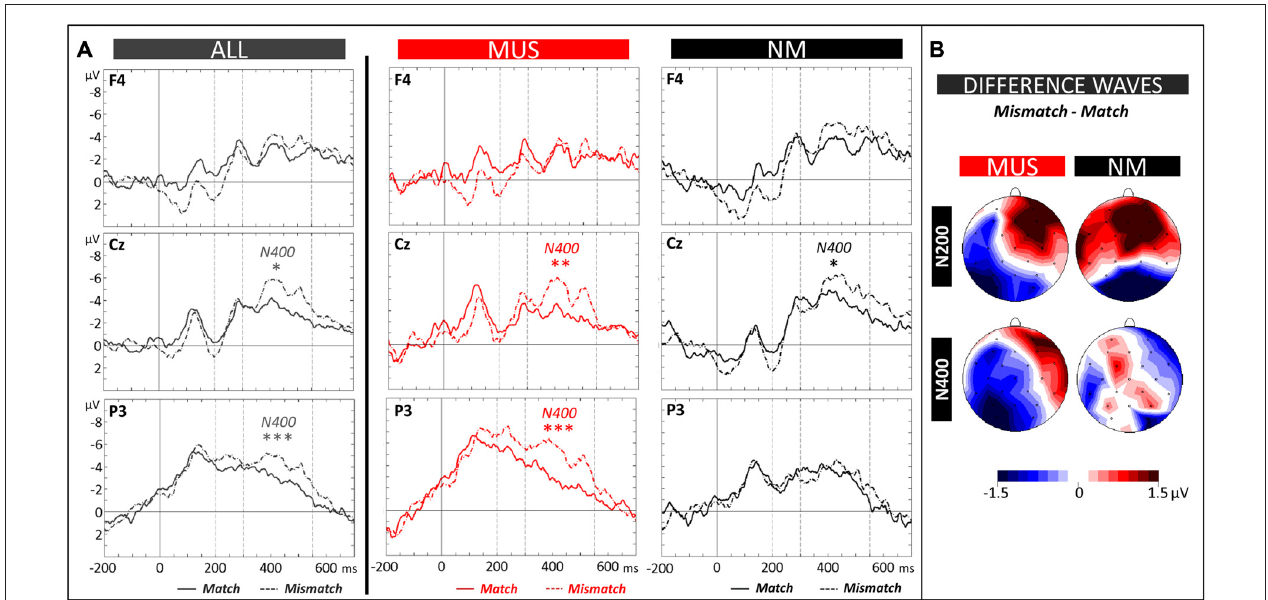
FIGURE 5 | Matching task. (A) ERPs recorded at representative electrodes (right frontal (F4), central (Cz) and left parietal (P3)) are overlapped for Match (solid lines) and Mismatch words (dotted lines), averaged across all children (ALL, dark gray lines) and for musician (MUS, red lines) and non-musician children (NM, black lines). Mean number of trials contributing to the averages (ALL = 1215, MUS = 634, NM = 581). (B) Topographic voltage distribution maps of the differences between conditions (Mismatch minus Match) are illustrated for the N200 and N400 and for MUS and NM. Voltage values are scaled from –1.5 µ V to +1.5 µ